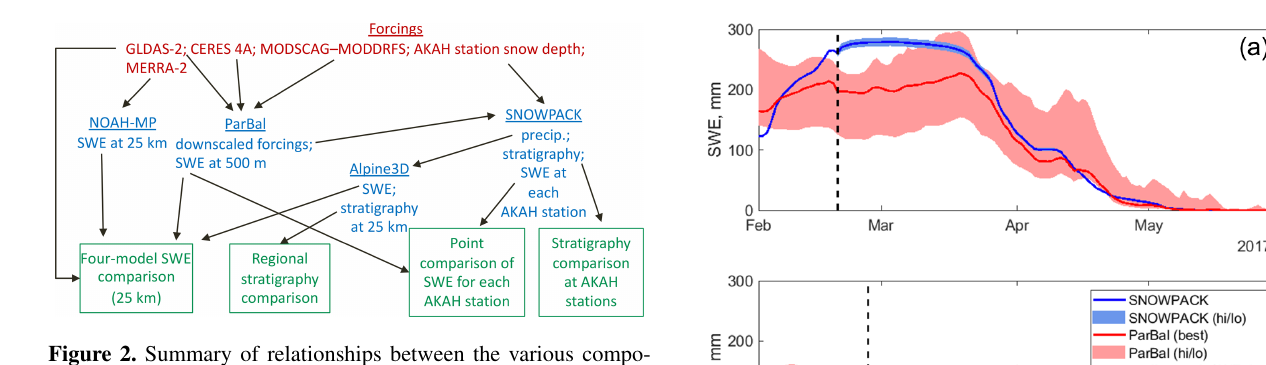
Figure 2. Summary of relationships between the various compo- nents. Forcings are shown in red, models and selected outputs are shown in blue, and the comparisons discussed below are shown in green. The black arrows show the direction of inputs.